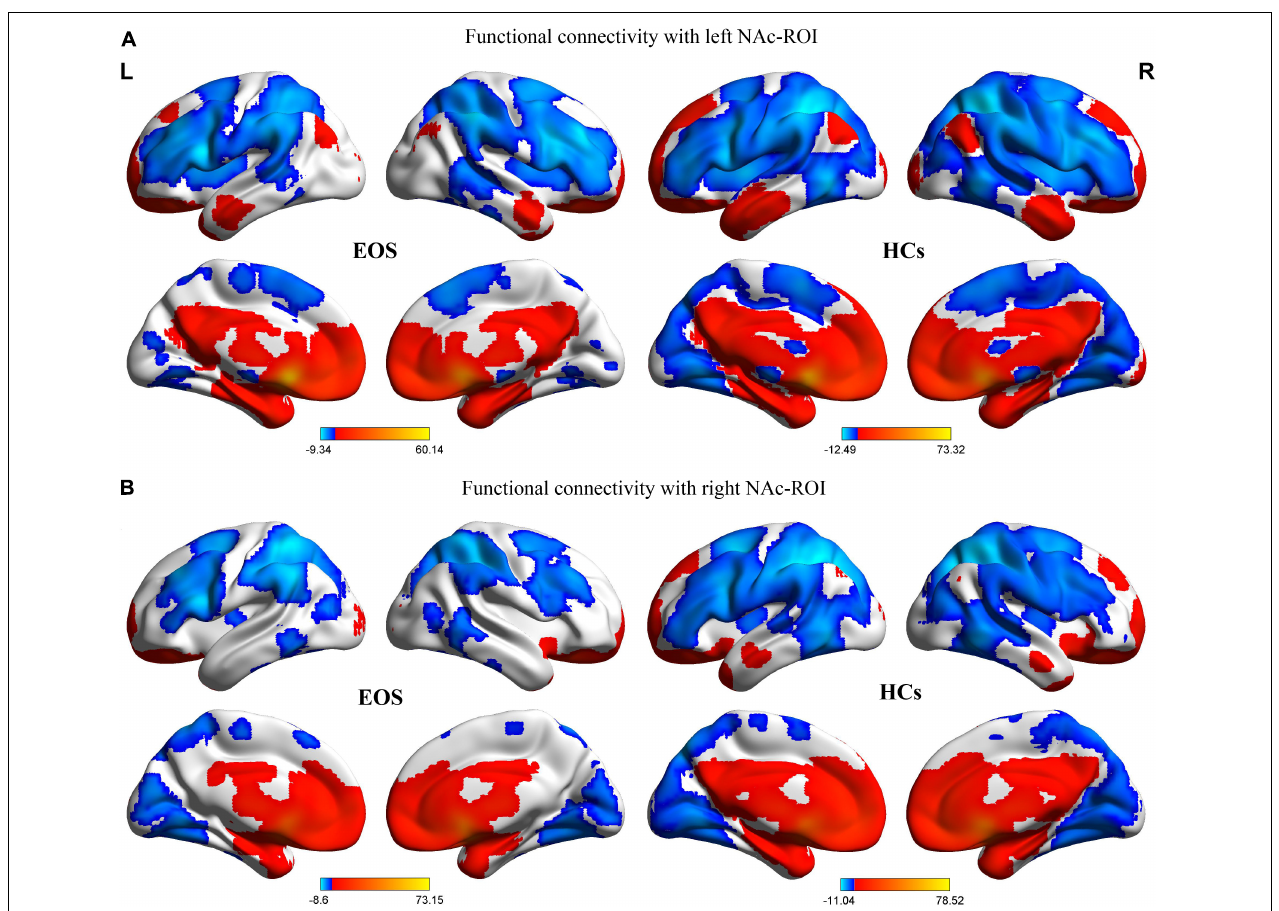
FIGURE 1 | Patterns of significant positive (red) and negative (blue) FC with bilateral NAc ROIs in the patients with EOS and HCs (GRF corrected, voxel level, p < 0.005; cluster level, p < 0.05; minimum clusters size of 50 voxels). The color bars show the range of t -values of the four one-sample t -tests, corresponding to FC patterns of the two group. (A) FC patterns with the left NAc ROI in the EOS and HCs groups. (B) FC patterns with the right NAc ROI in the EOS and HCs groups. FC, functional connectivity; NAc, nucleus accumbens; ROI, region of interest; EOS, early-onset schizophrenia; HCs, healthy controls; L, left; R,